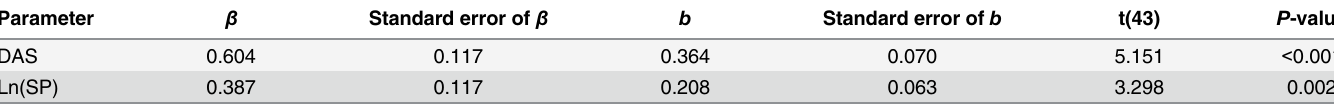
Table 4. Results of the regression analysis for chronic pain intensity according to NPS depending on the disease activity score (DAS) and the log- arithmic concentration of substance P – ln (SP) for the group of patients with RA after removing the intercept. Parameter β Standard error of β